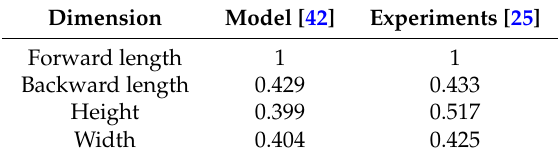
Table 22. Comparison of the model-predicted cavity dimension with the experiments